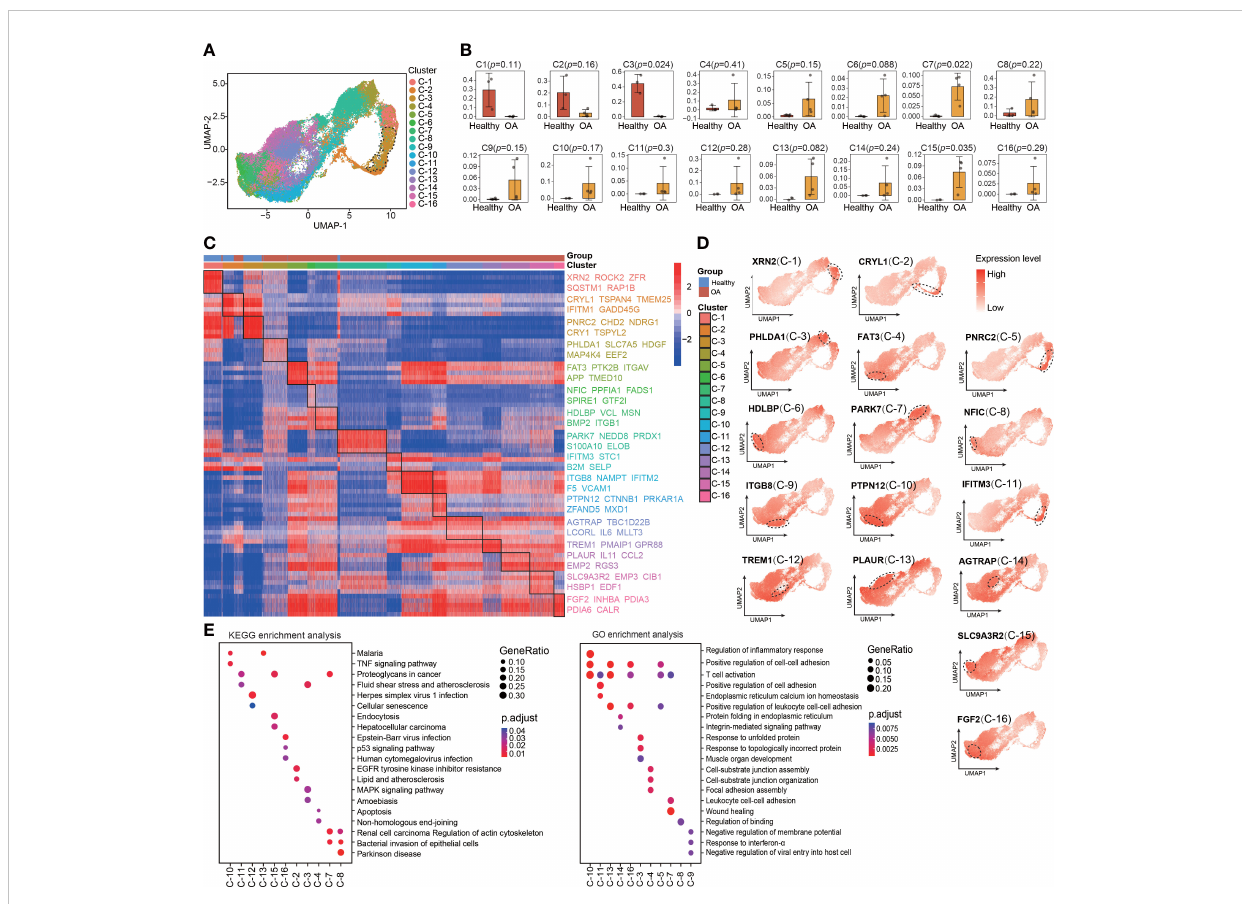
FIGURE 2 Identi fi cation of chondrocyte populations and master regulators from VIPER-Inferred protein activity. (A) Visualization of umap colored according to cell clusters for VIPER-Inferred protein activity across all normal and OA samples. (B) Bar plots showing the comparison of different cell clusters by VIPER-inferred activity between normal and OA samples. (C) Heatmap of the scaled expression of top 5 master regulator proteins of various cell clusters from inferred proteomic data. (D) Dot plots showing the top 1 master regulator proteins based on VIPER-inferred protein activity for each viper cluster on the umap. Each dotted line circle in the dot plots represents a viper cluster. Dot colour corresponds to the level of gene expression in each cell. (E) Dot plot showing the signi fi cant signaling pathways and biological processes identi fi ed by GO and KEGG enrichment analysis from inferred proteomic data. All data are expressed as the mean ± SD. Student ’ s t test was used for statistical analysis. p < 0.05 was considered statistically signi fi